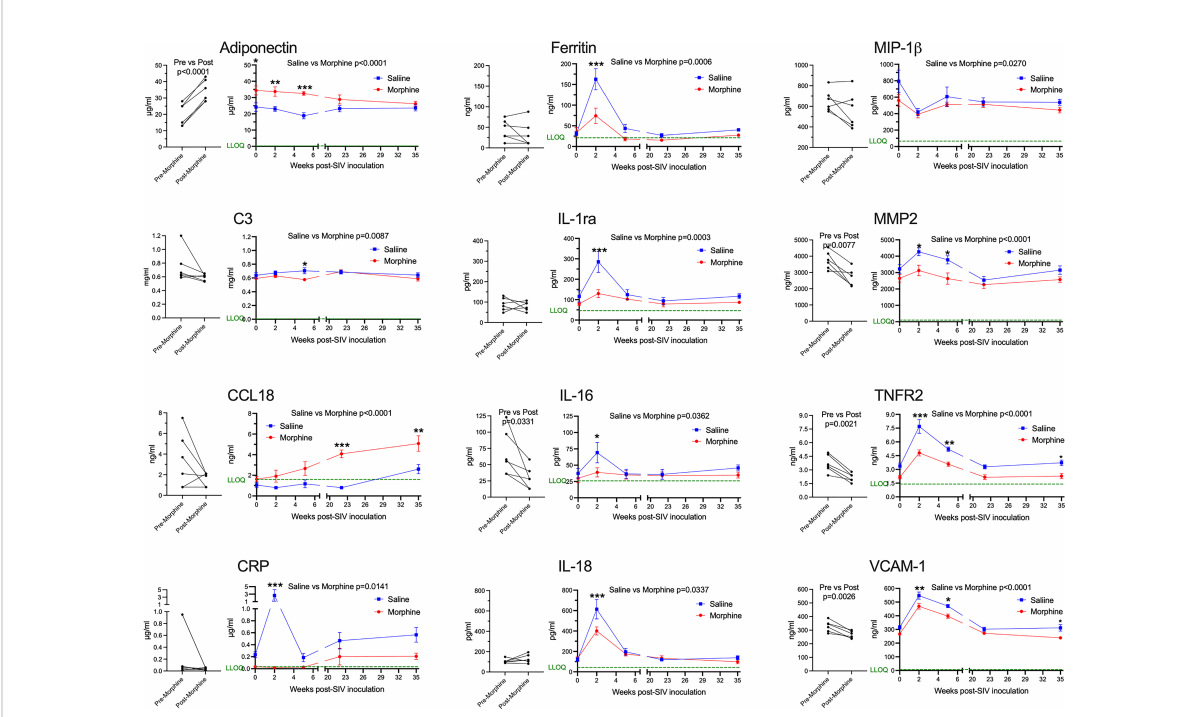
FIGURE 2 Plasma biomarkers. A panel of plasma proteins was assessed before and after morphine administration in the morphine group, and then throughout infection in both the morphine (red) and saline (blue) groups. The left panel for each analyte contains the pre- and post-morphine (before SIV inoculation); statistical testing was performed by paired t-test. The right panels show values starting on the day of inoculation (week 0), and then week 2 (acute), week 5 (immediately before cART administration began), and then with viremia suppressed by cART, week 22 and week 35. The points represent the mean and the error bars the standard error of the mean. Statistical testing was done by 2-way ANOVA and reported for signi fi cant differences between the groups. When the ANOVA was signi fi cant, testing on the individual time points were performed using Sidak ’ s multiple comparison test. * = <0.05, ** = < 0.01, *** = < 0.001. LLOQ = lower limit of quantitation, shown as a green line. One- half the LLOQ value was used for nonquanti fi able values